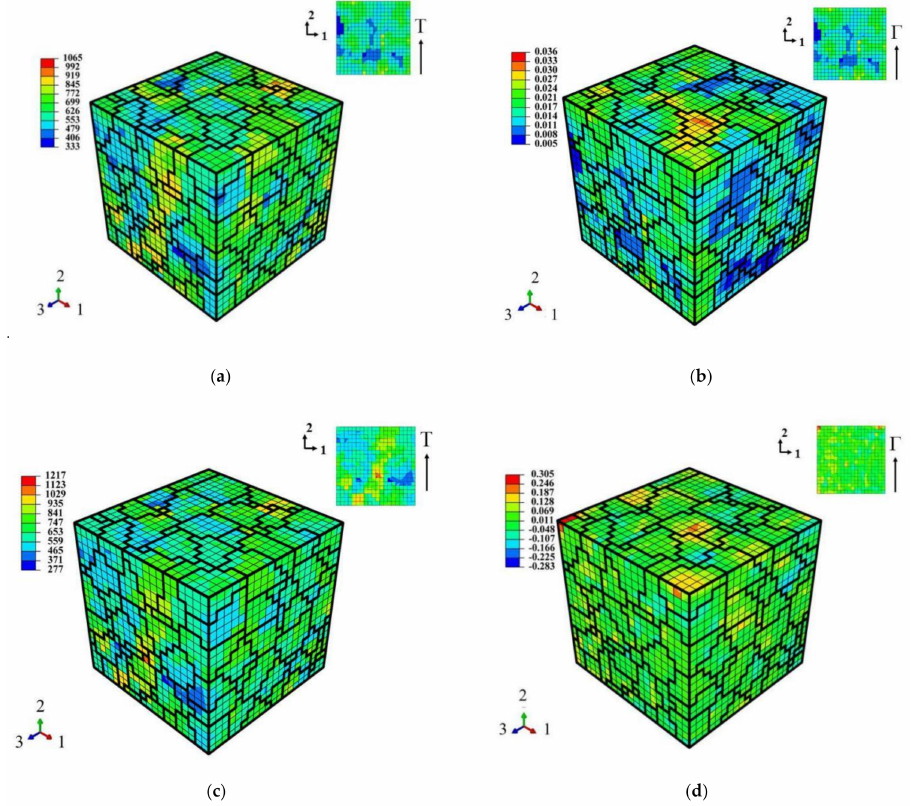
Figure 10. ( a , b ) Shear stress and strain contours at the shear stress peak of the 7th cycle, respectively; ( c , d ) Shear stress and strain contours at the shear stress peak of the 560th cycle, respectively. Shear √ strain amplitude is γ a / 3 =